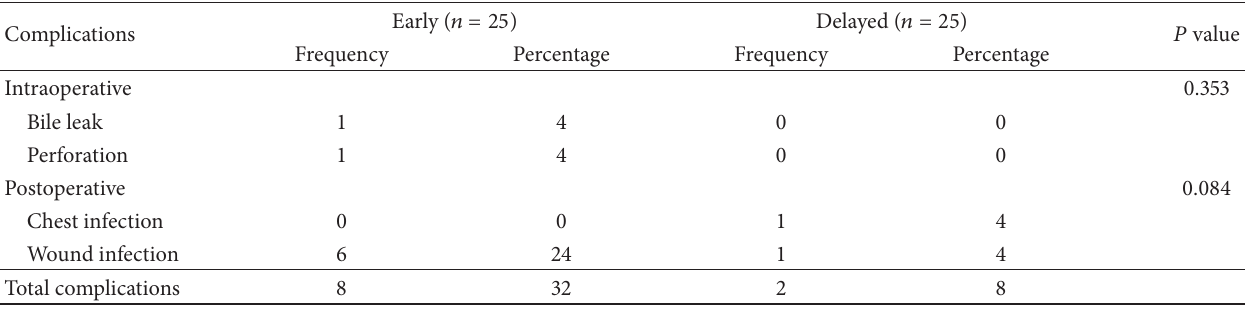
Table 4: Comparison of operative complications in early and delayed groups.